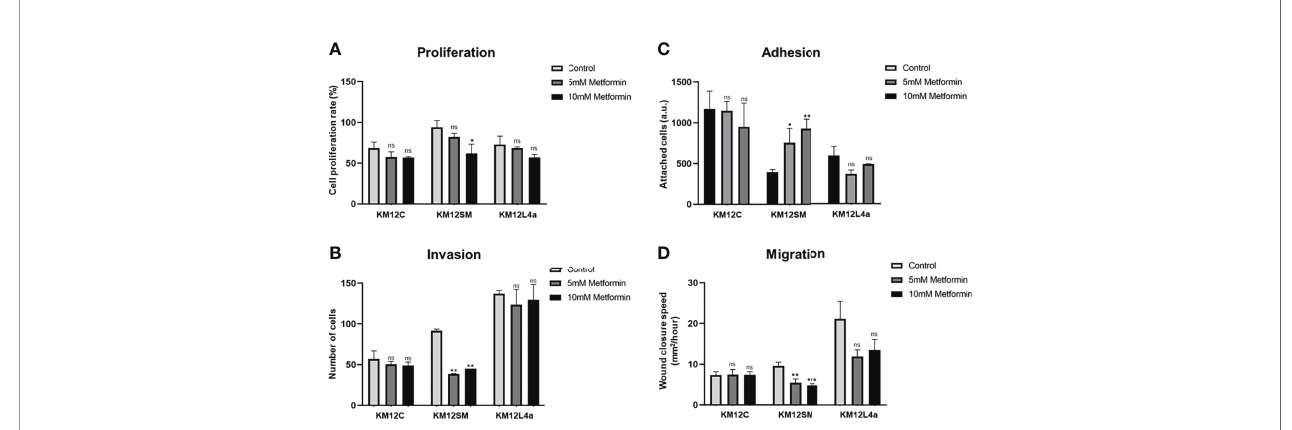
FIGURE 4 | Analysis of the effect of metformin on the tumorigenic and metastatic properties of CRC isogenic cells with metastatic and non-metastatic properties. (A) Proliferation, (B) invasion, (C) adhesion, and (D) migration abilities of KM12 cells in the presence or absence of 10 – 15 mM metformin are represented. Wound closure speed is referred to wound size differences between 0 and 62 h of each experiment. KM12SM metastatic cells were the most affected by this complex I inhibitor compound, suggesting that these cells are not able to respond to increased cellular stress. * p value < 0.05; ** p value < 0.01; *** p value <